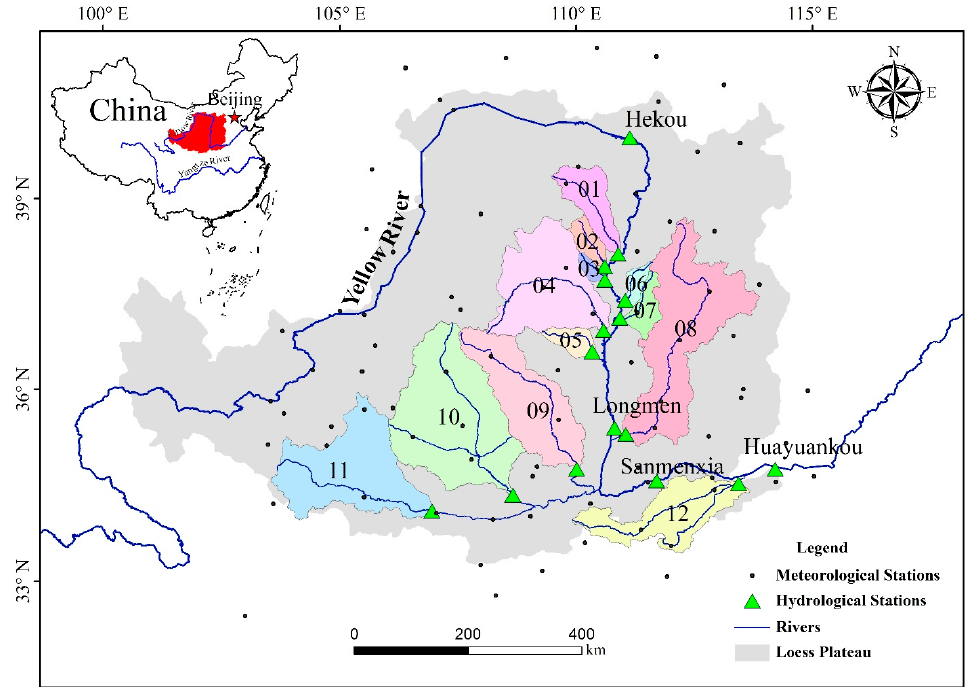
Figure 1. Distribution of basins used in the study. The four main hydrological stations are Hekou, Longmen, Sanmenxia, and Huayuankou. Longmen, Sanmenxia, and